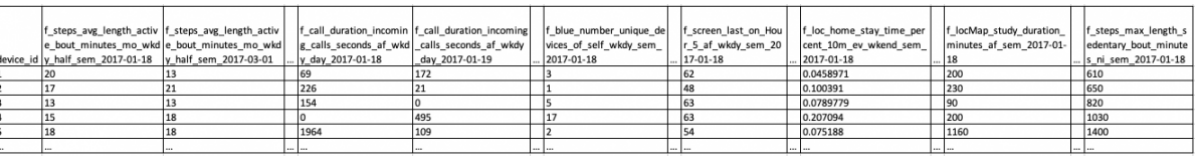
Figure 3. The schema of the feature matrix used in the machine learning pipeline (each column is a feature and each row is a sample per participant).